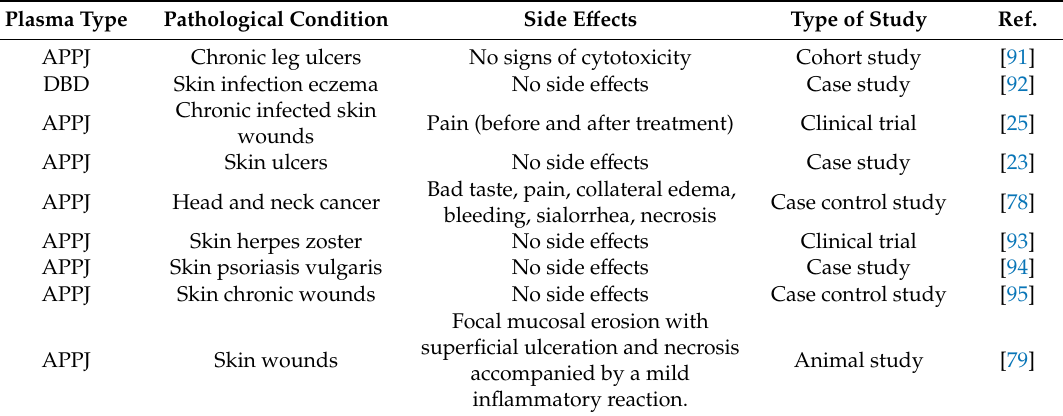
Table 2. Studies that assessed side e ff ects of